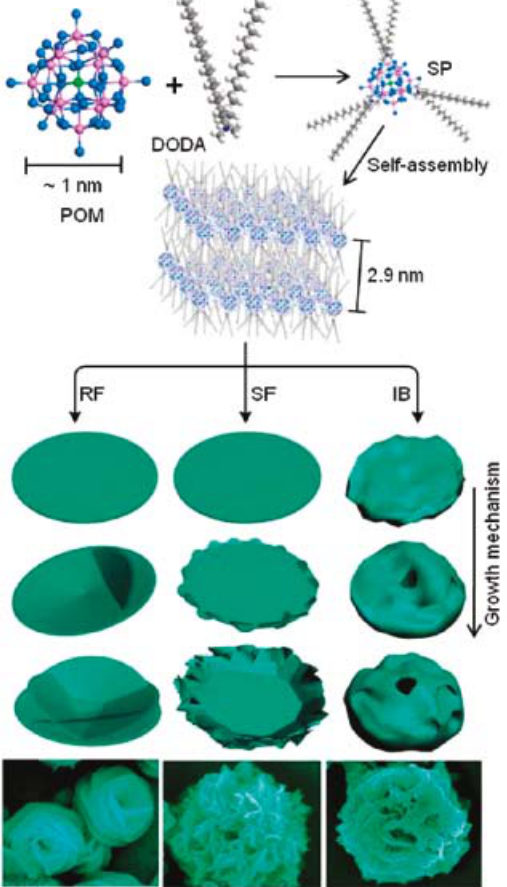
Fig. 13. POM cluster combined with surfactant cation to form the POM supramolecular nanobuilding block (SP) that is subsequently self-assembled in specific nanoenvironment to produce rose flowers (RF), snow flowers (SF), and ice balls (IB). Adapted from Ref [69].